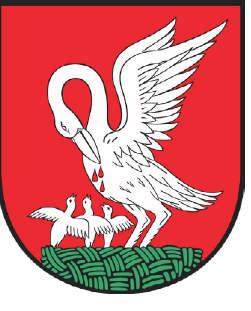
Figure 8. The arms of Grabów at the Prosna River.